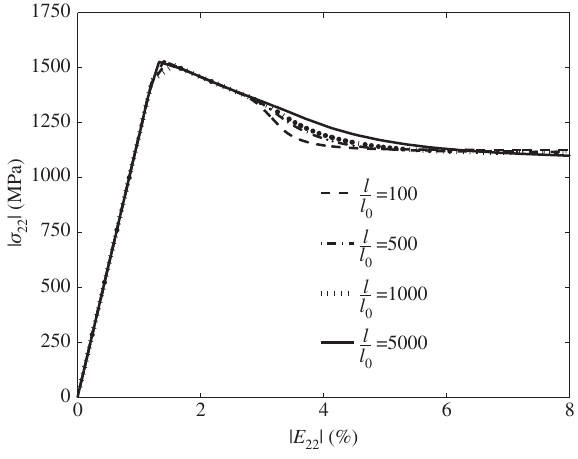
Figure 9 Sample S , length scale-dependent behavior: average stress 1 component | σ | over applied strain | E 22 l different ratios of internal length l and external specimen size l l 0